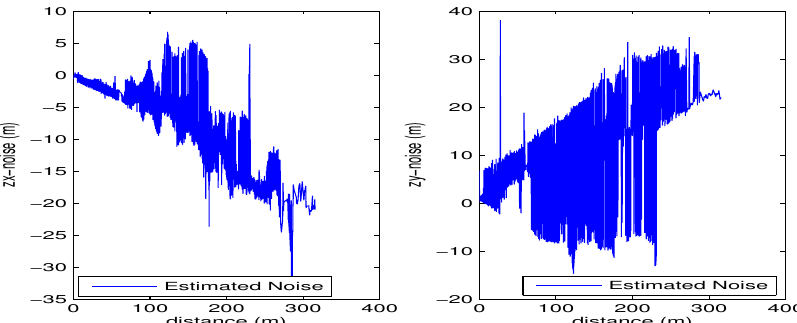
Figure 6. The estimated measurement error data according to method 1.